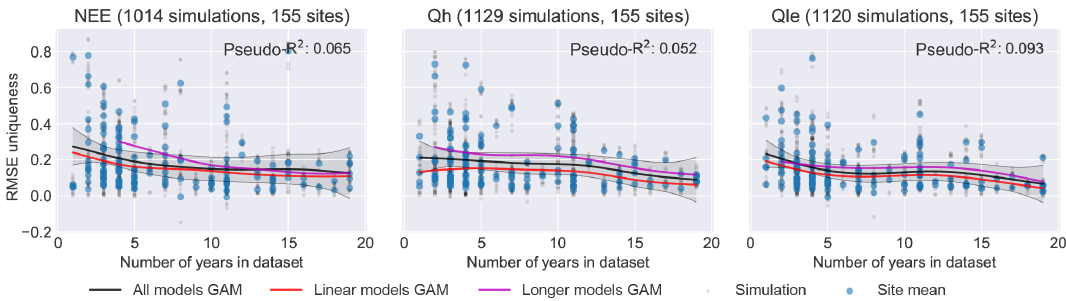
Figure 8. RMSE uniqueness for number of years in a